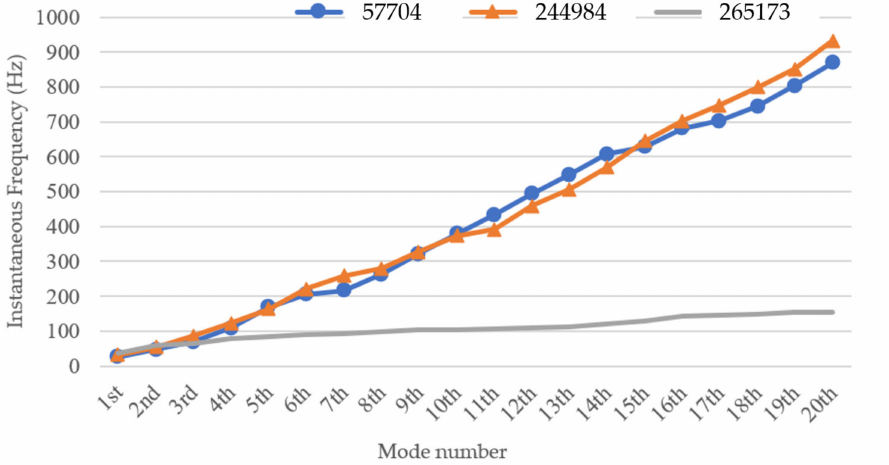
Figure 20. Instantaneous frequencies of decomposed signals of the first 20 modes of the three wooden utility